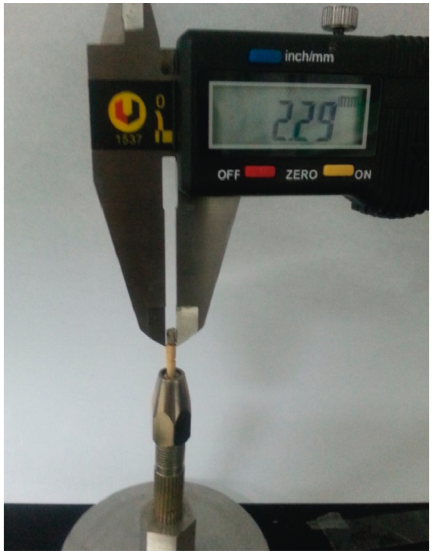
Figure 1: Picture of a coal